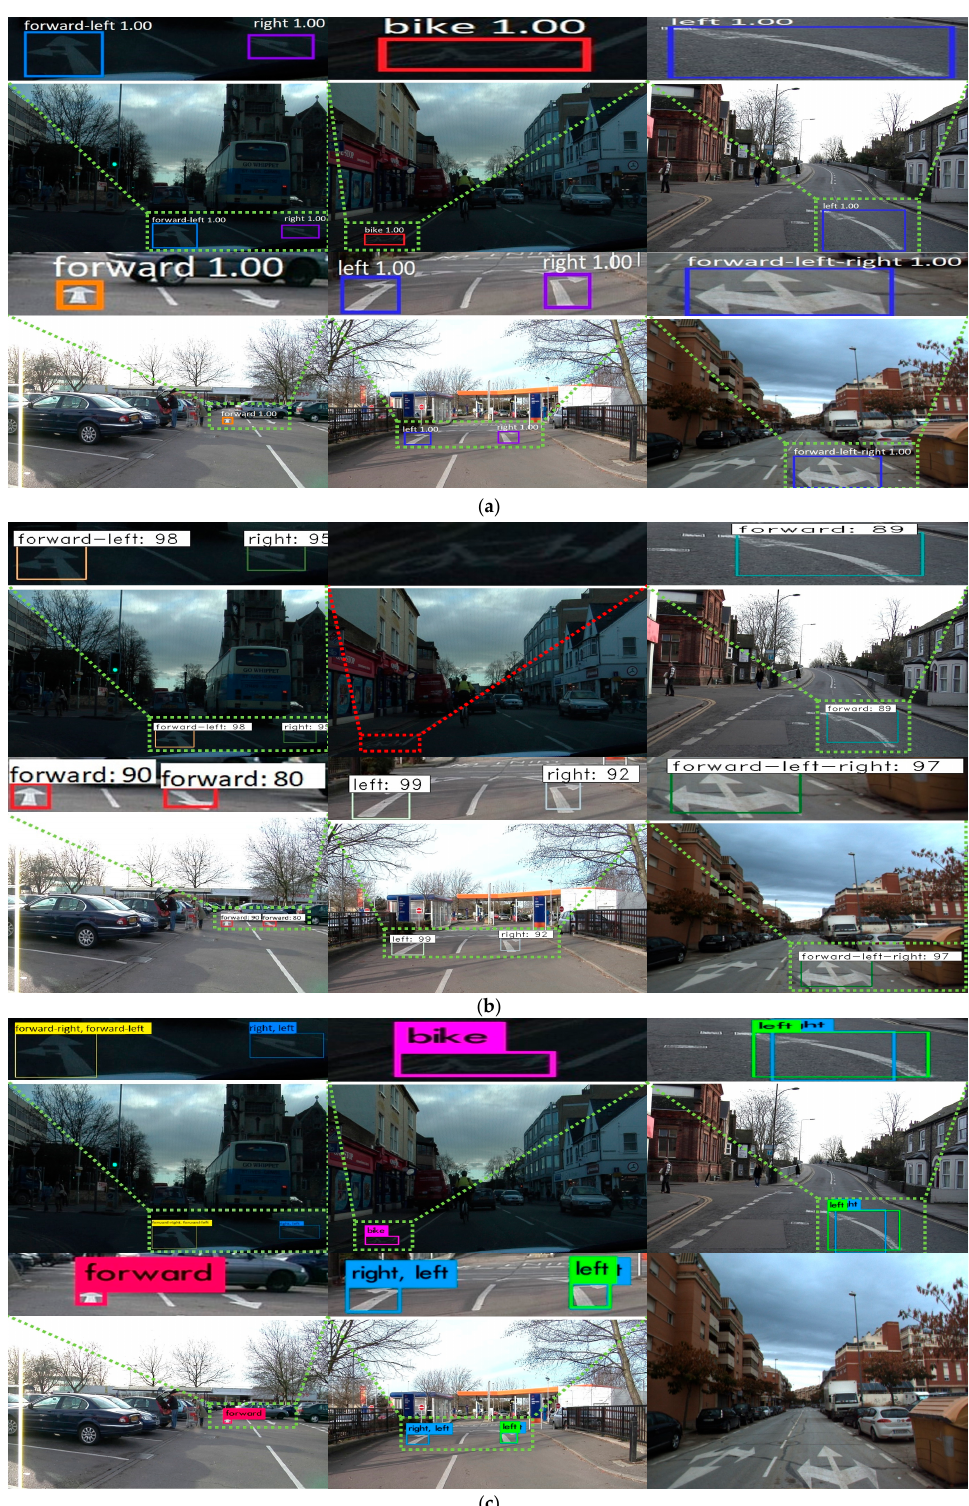
Figure 13. Comparison of road marking detection: ( a ) Proposed method. ( b ) Faster R-CNN. ( c )